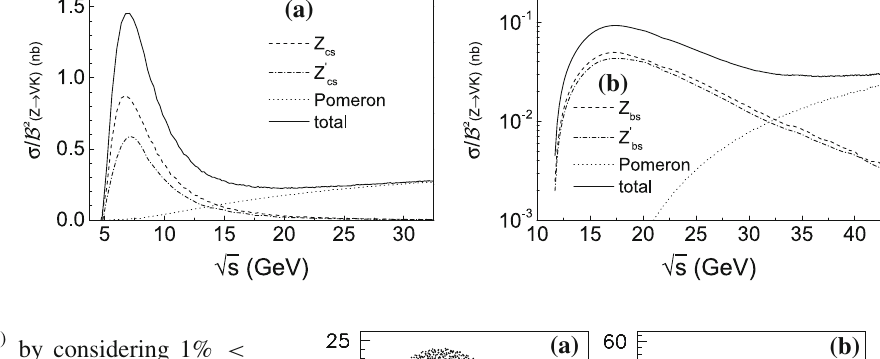
√ s = 8 . 0GeV and (b,d) γ p → (cid:3)ϒ K at √